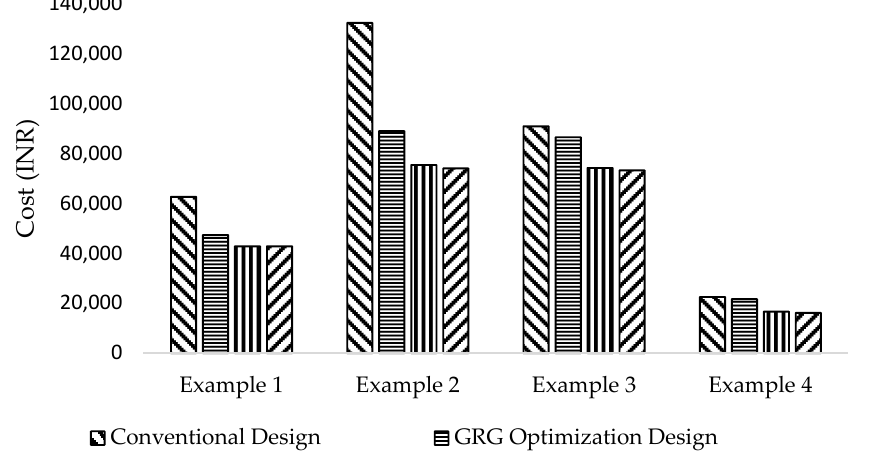
Figure 7. Comparison of obtained cost for examples 1–4.